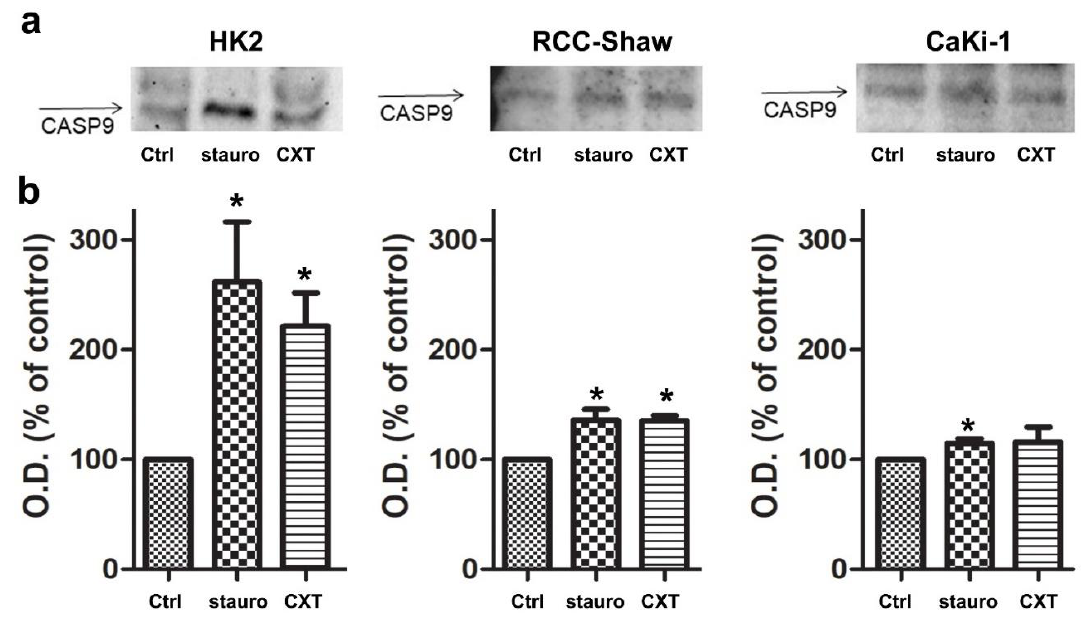
Figure 5. Quantification of Cleaved-CASP9 in HK2, RCC-Shaw, and CaKi-1 cells. Panel ( a ). Representative western blots are reported. Panel ( b ). Data obtained by the optical density of cleaved-CASP9 immunoreactivity bands were expressed as a percentage of the controls. Values represent mean ± S.E. ( n = 3). * p < 0.05, nonparametric Wilcoxon test between cell lines treated with staurosporine (stauro) or carboxyatractyloside (CXT) and non-treated cells (Ctrl).